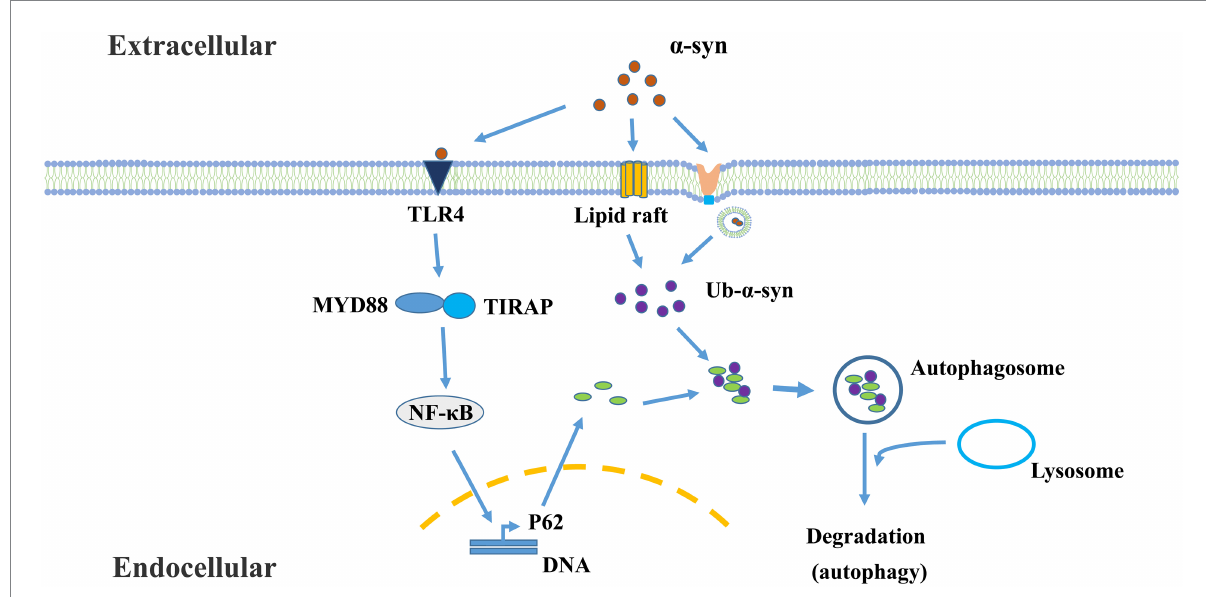
FIGURE 2 The mechanism of microglial synucleinphagy. Microglia ingest extracellular α -syn protein, which is sequestered by the autophagy-lysosome pathway. This process is mediated through TLR4-NF- κ B signaling, and leads to the endocytosis- and phago-independent ingestion of extracellular α -syn. In this process, α -syn-TLR4 interaction stimulates p62 expression mediated by NF- κ B. Meanwhile, α -syn can enter the cells or penetrate cytoplasmic membrane through other endocytosis-independent processes [such as lipid raft (Park et al., 2009)] or endocytosis-dependent processes (Lee et al., 2008a). Then, oligomeric p62 binds and recruits ubiquitinated- α -Syn (Ub- α -Syn) into autophagosomes for